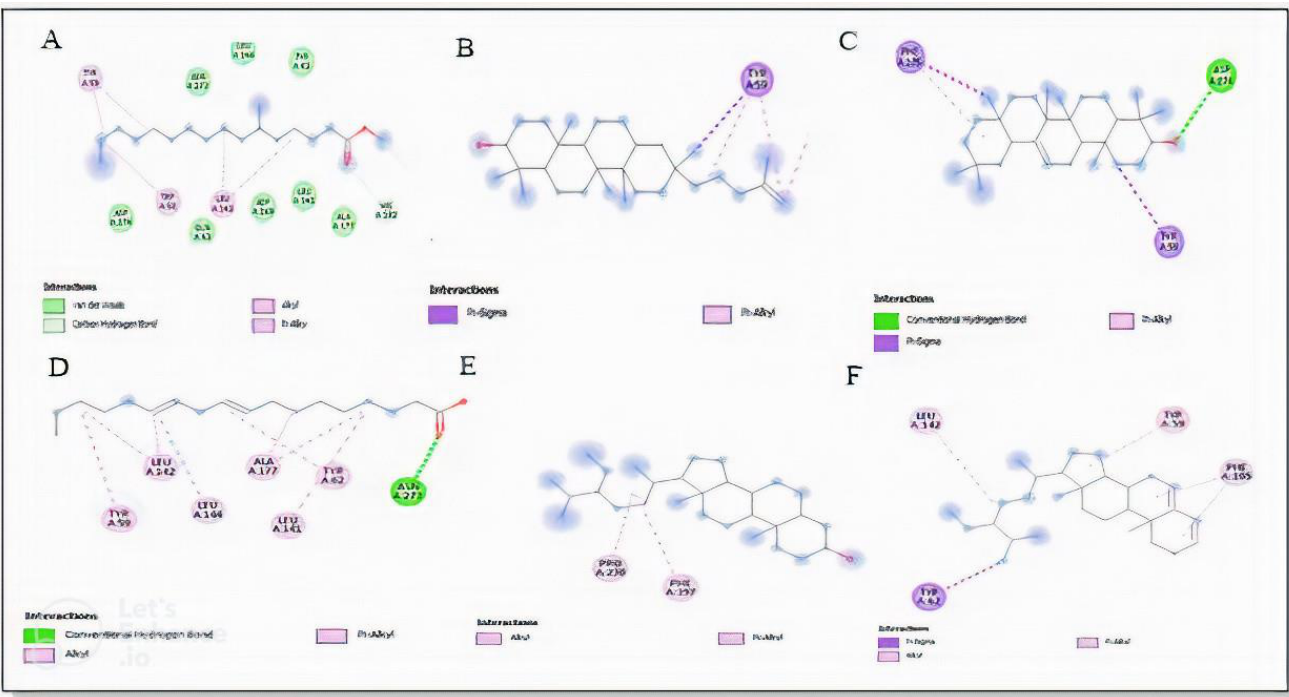
Figure 5. Enzyme α -amylase and ligands interaction. Hexadecanoic acid ( A ), Lupeol ( B ), β -Amyrin ( C ), Octadecadienoic acid ( D ), Sitosterol ( E ), Stigmasterol ( F ).